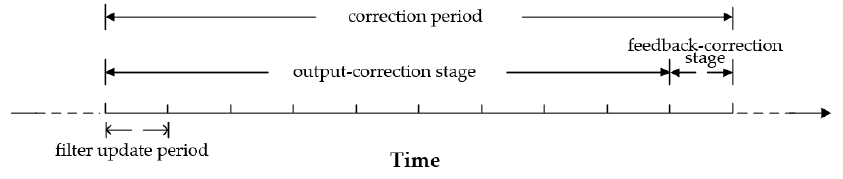
Figure 6. Description of the correction period.